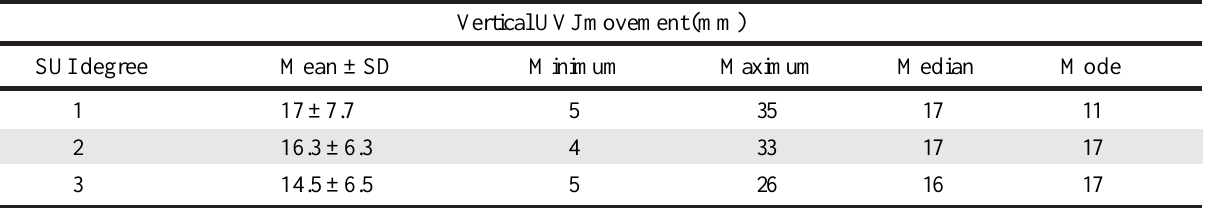
TABLE 4 - Behavior of the vertical UVJ movement on perineal ultrasound with a barely empty bladder according to the degree of